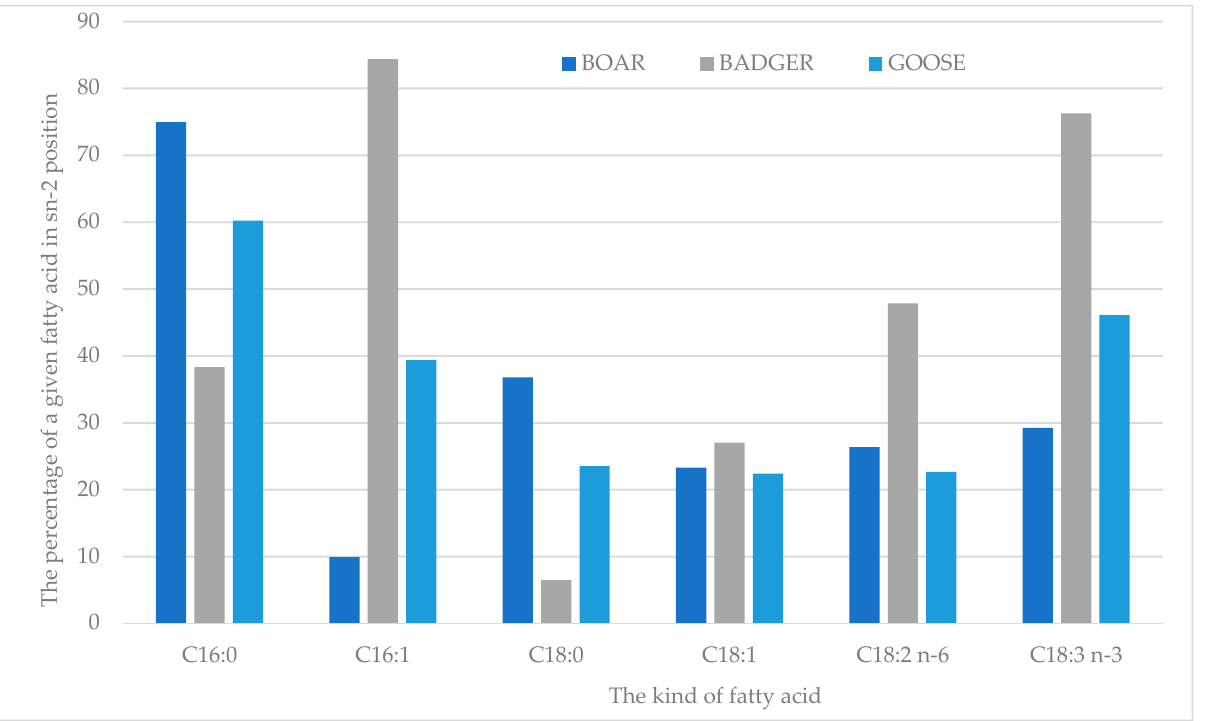
Data expressed as means ± SD. a,b The different lower case letters in the same column (for the position sn-2 and sn-1,3 separately) indicate significantly different values ( p ≤ 0.05). H—Kruskal-Wallis statistics. **—significant at level 0.01, NS —not significant.